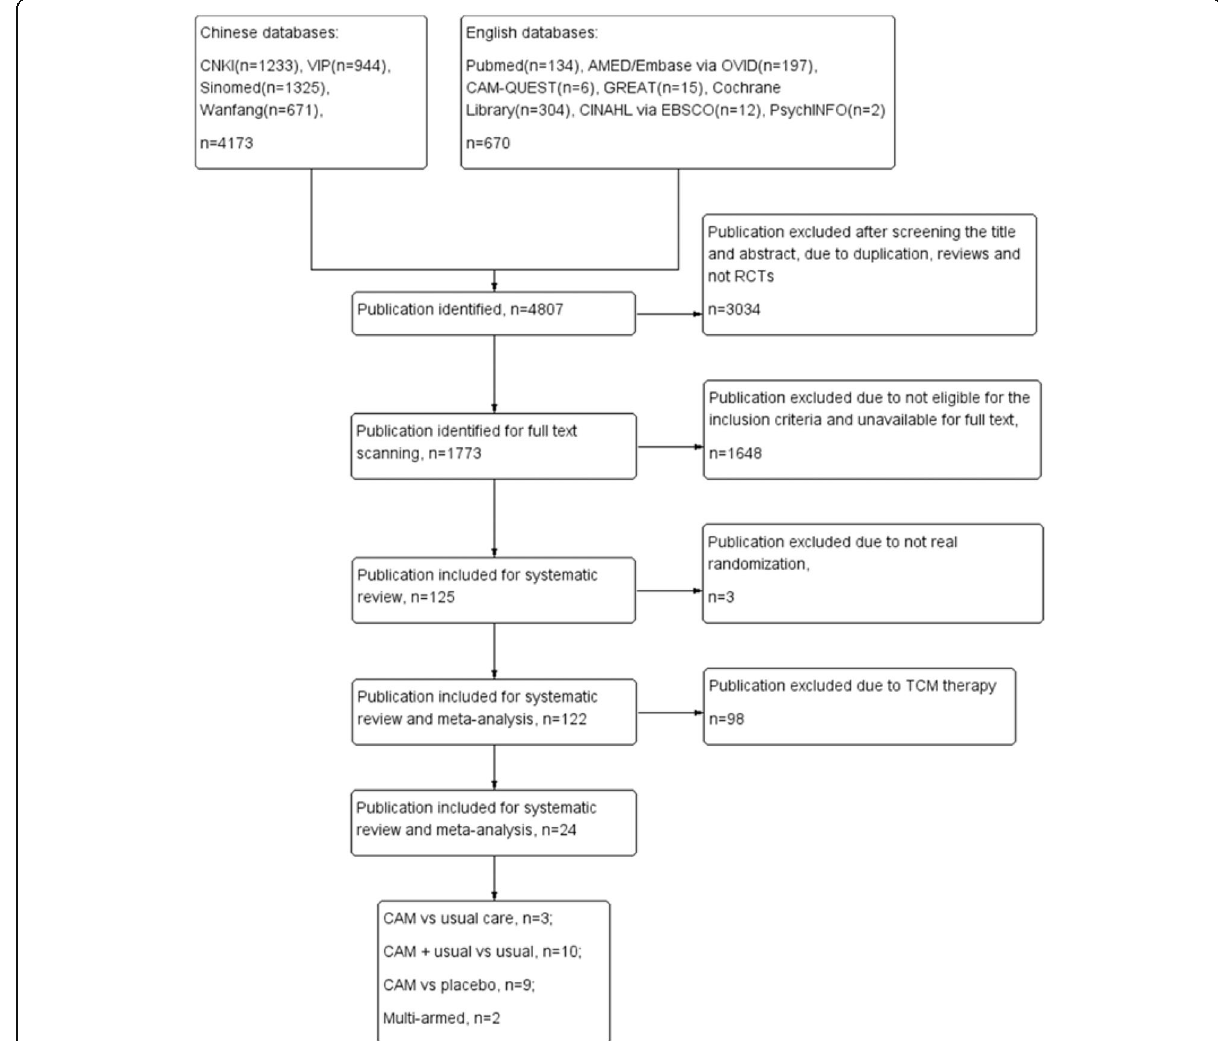
Fig. 1 Flow diagram of study selection and different sub-groups interventions included in this